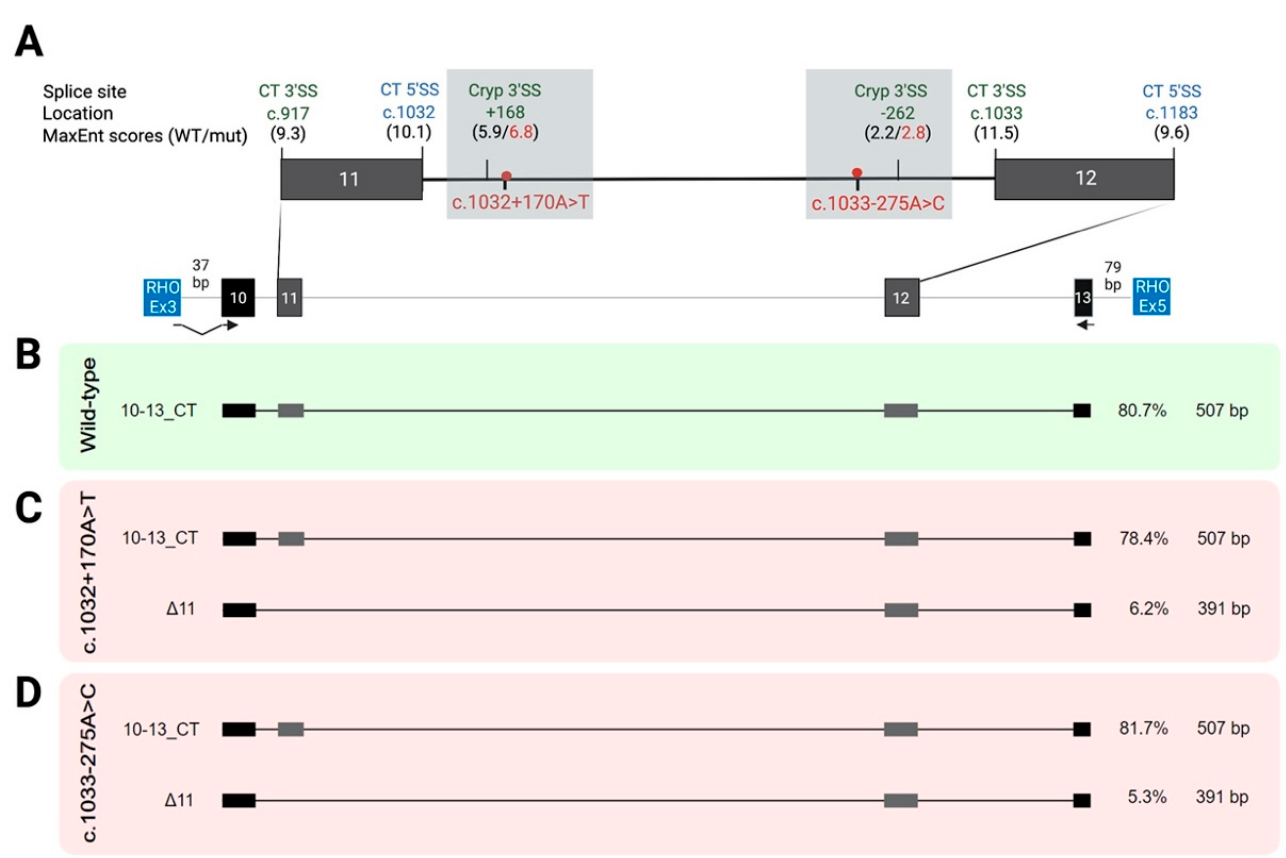
Figure 2. Splicing outcomes for two spliceogenic deep-intronic variants located in intron 11 of PAX6 using in vitro minigene assays. ( A ) Schematic representation of the multi-exonic